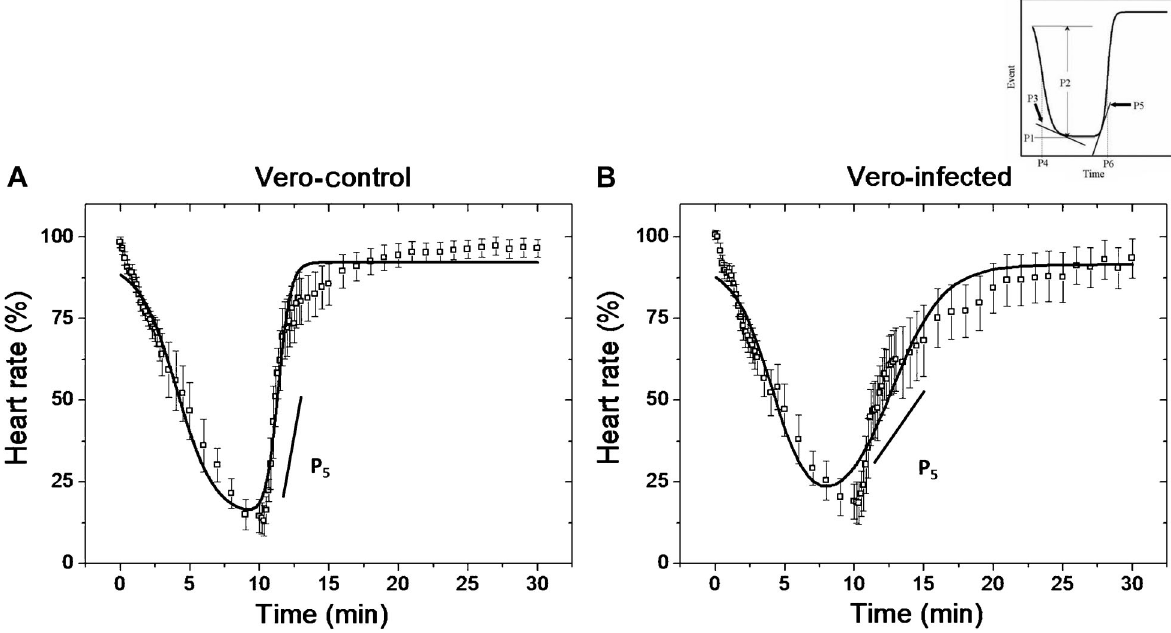
Figure 2. Average heart rate (HR) during the ischemia-reperfusion process. Dotted lines represent the mean ± SE HR in all ischemia- reperfusion cycles. Panel A shows the data of Vero-control-perfused hearts (n = 12), and Panel B shows data of Vero-infected- perfused hearts (n = 14). Continuous lines are the results of the fitting of Equation 1, and parameters are shown in the